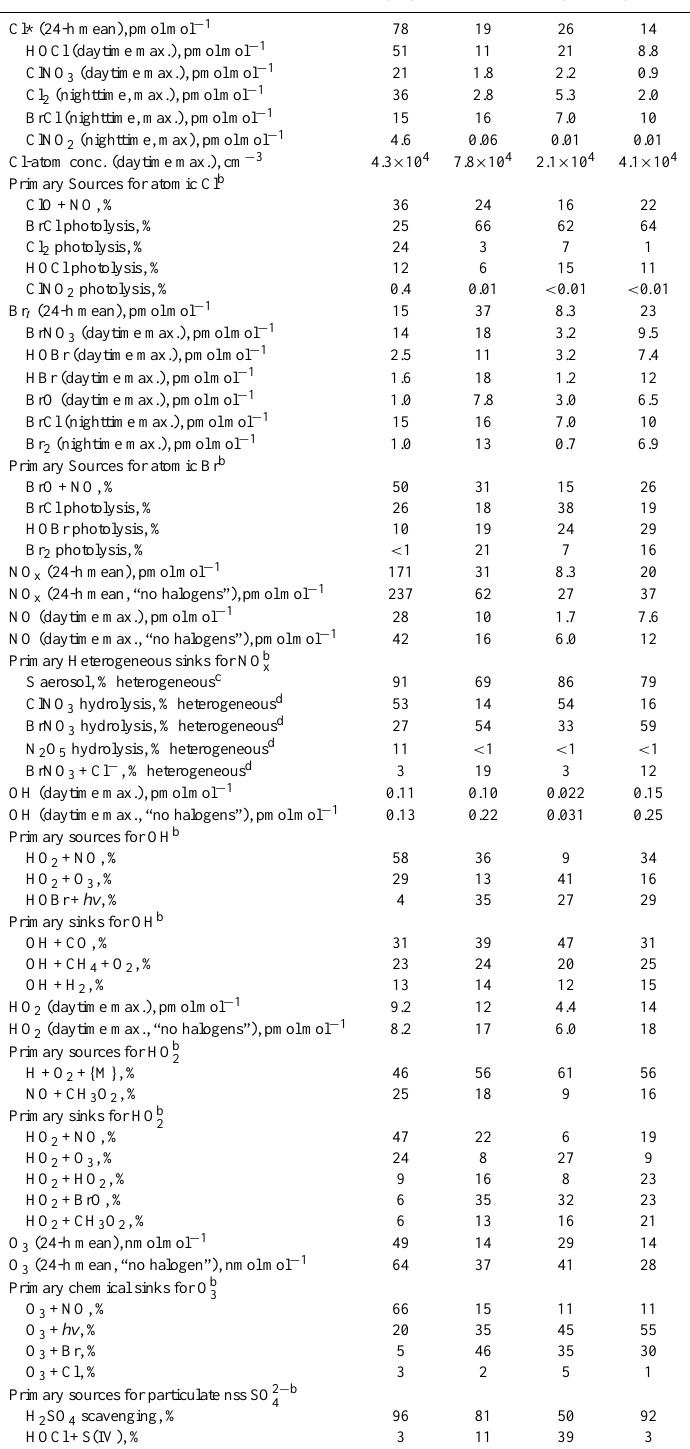
Table 4. Simulated characteristics of each flow